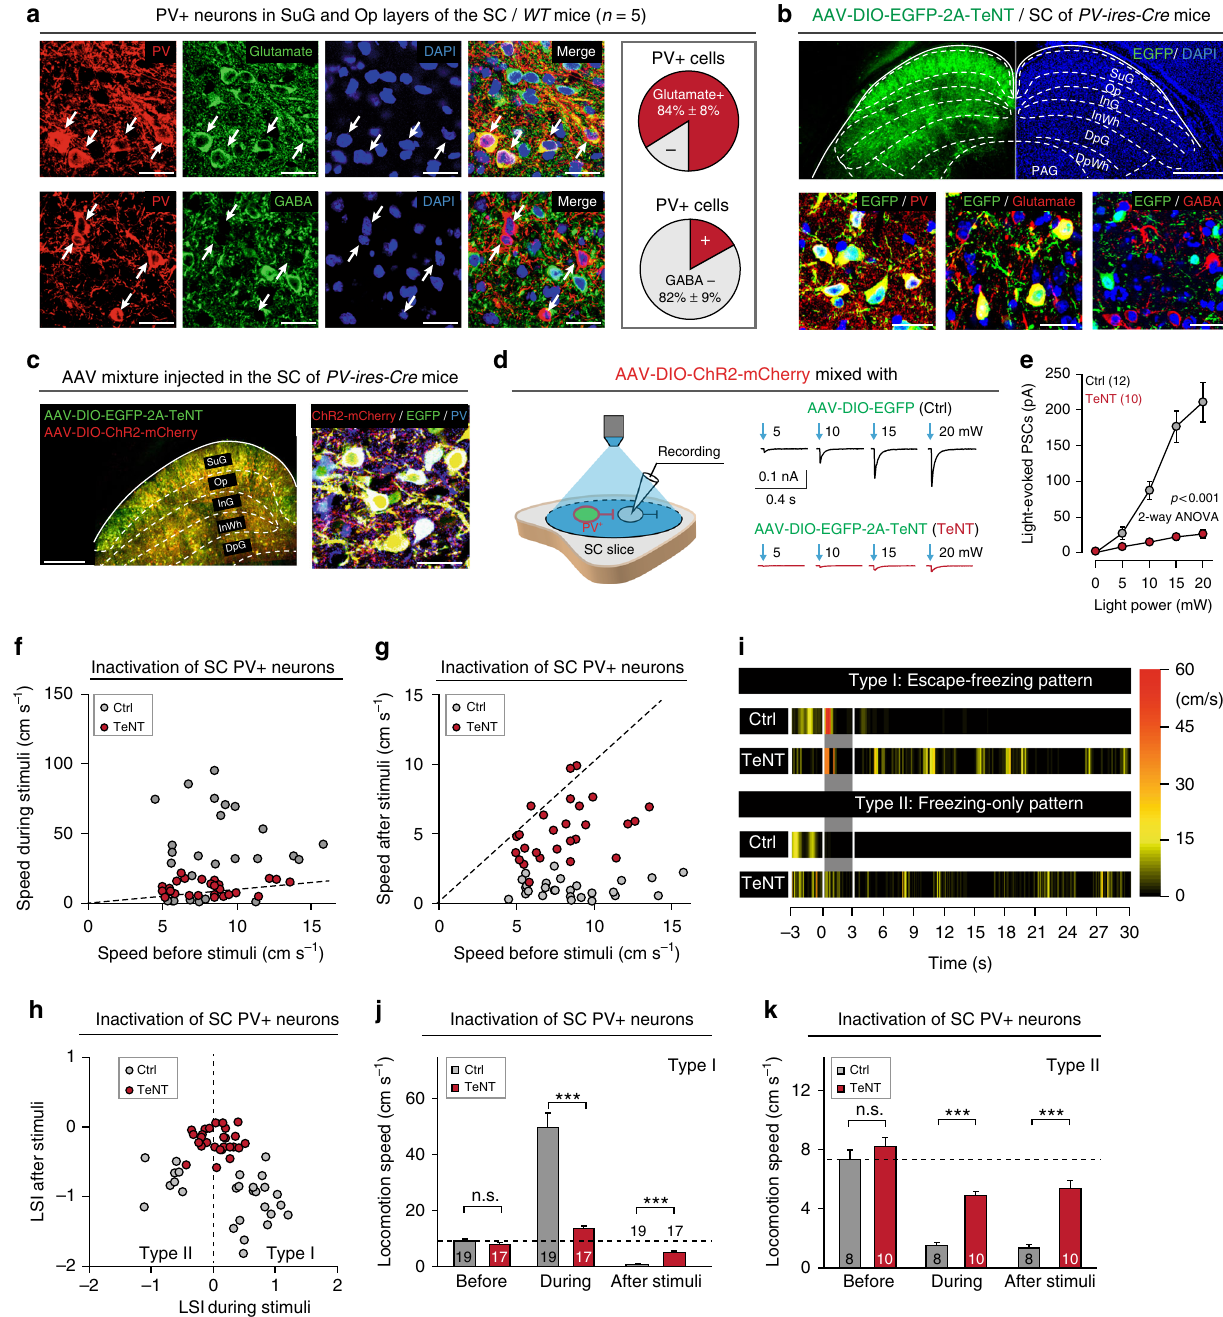
Fig. 2 SC PV + neurons are essential for visually triggered dimorphic defensive behaviors. a Left, Micrographs showing immunostaining of PV vs. glutamate (top) or PV vs. GABA (bottom) in SuG layer of the SC. Arrows indicate PV + neurons. Right, quantitative analyses indicating most SC PV + neurons in SuG and Op layers are glutamate + and GABA − . Scale bars, 30 μ m (top) and 35 μ m (bottom). b Coronal SC section (top) and micrographs (bottom) of PV-ires- Cre mice injected with AAV-DIO-EGFP-2A-TeNT, showing expression of EGFP in SC neurons positive for PV, glutamate but negative for GABA. Scale bars, 0.5 mm (top) and 30 μ m (bottom). c Coronal SC section (left) and micrograph (right) showing SC PV + neurons co-labeled by EGFP and ChR2-mCherry after injection of AAV-DIO-EGFP-2A-TeNT and AAV-DIO-ChR2-mCherry mixture into the SC of PV-ires-Cre mice. Scale bars, 0.3 mm (left) and 20 μ m (right). d Schematic diagram of slice physiology (left) and example traces (right) showing neurotransmitter release from SC PV + neurons was blocked by TeNT. e Input − output curves of light-evoked PSCs recorded from ChR2-negative neurons. f , g Distribution of speed during vs. before ( f ) and after vs. before ( g ) visual stimuli of mice with active (Ctrl) or inactive (TeNT) SC PV + neurons. h Distribution of LSI during stimuli and LSI after stimuli of mice with active (Ctrl) or inactive (TeNT) SC PV + neurons. i Heat-maps of speed time course of example mice with active (Ctrl) or inactive (TeNT) SC PV + neurons. j , k Effects of synaptic inactivation of SC PV + neurons on locomotion speed of mice with Type I ( j ) and Type II ( k ) defensive behavioral patterns. For single- channel micrographs ( b , c ), see Supplementary Fig. 3. Data in ( e , j , k ) are means± SEM (error bars). Numbers of cells or mice are indicated in the graphs. Statistical analysis was Student ’ s t test (*** P < 0.001; n.s. P > 0.1) and one-way